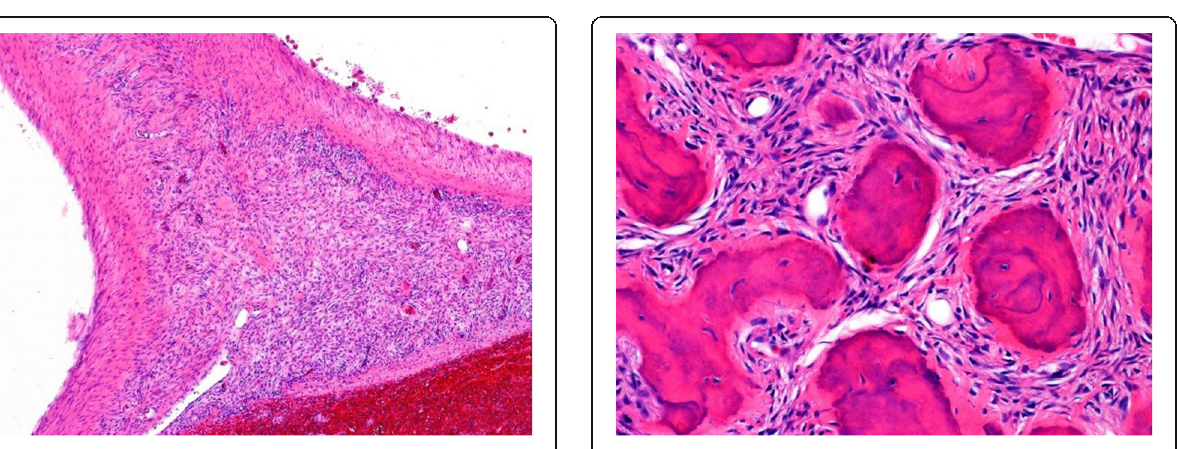
Fig. 3 Cystic spaces (asterisks) are part of the multilocular aneurysmal bone cyst. A peripheral extension of the solid tumour is seen in the centre